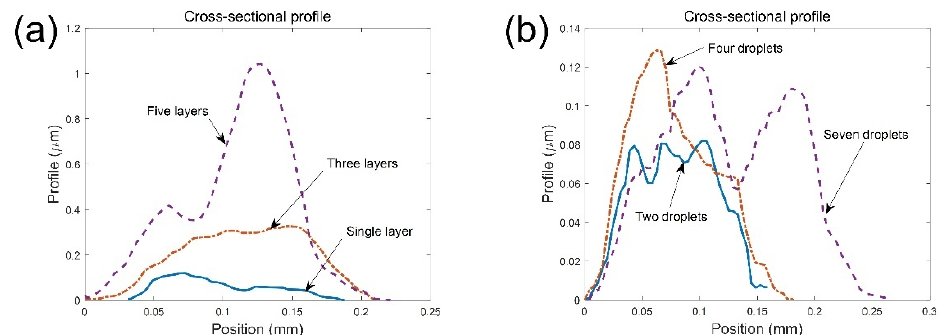
Figure 4. Cross-sectional profiles of printed strain-gauge patterns as a function of ( a ) the number of stacked layers and ( b ) the width. Table 1. Statistical evaluation of measured resistances of the printed strain-gauge patterns. Figure 3. ( a ) Design of the printed strain gauge. ( b ) Resistance variations of the printed strain gauges. Blue and orange bars are for stacked layers and different widths, respectively. Data are mean and standard deviation values.